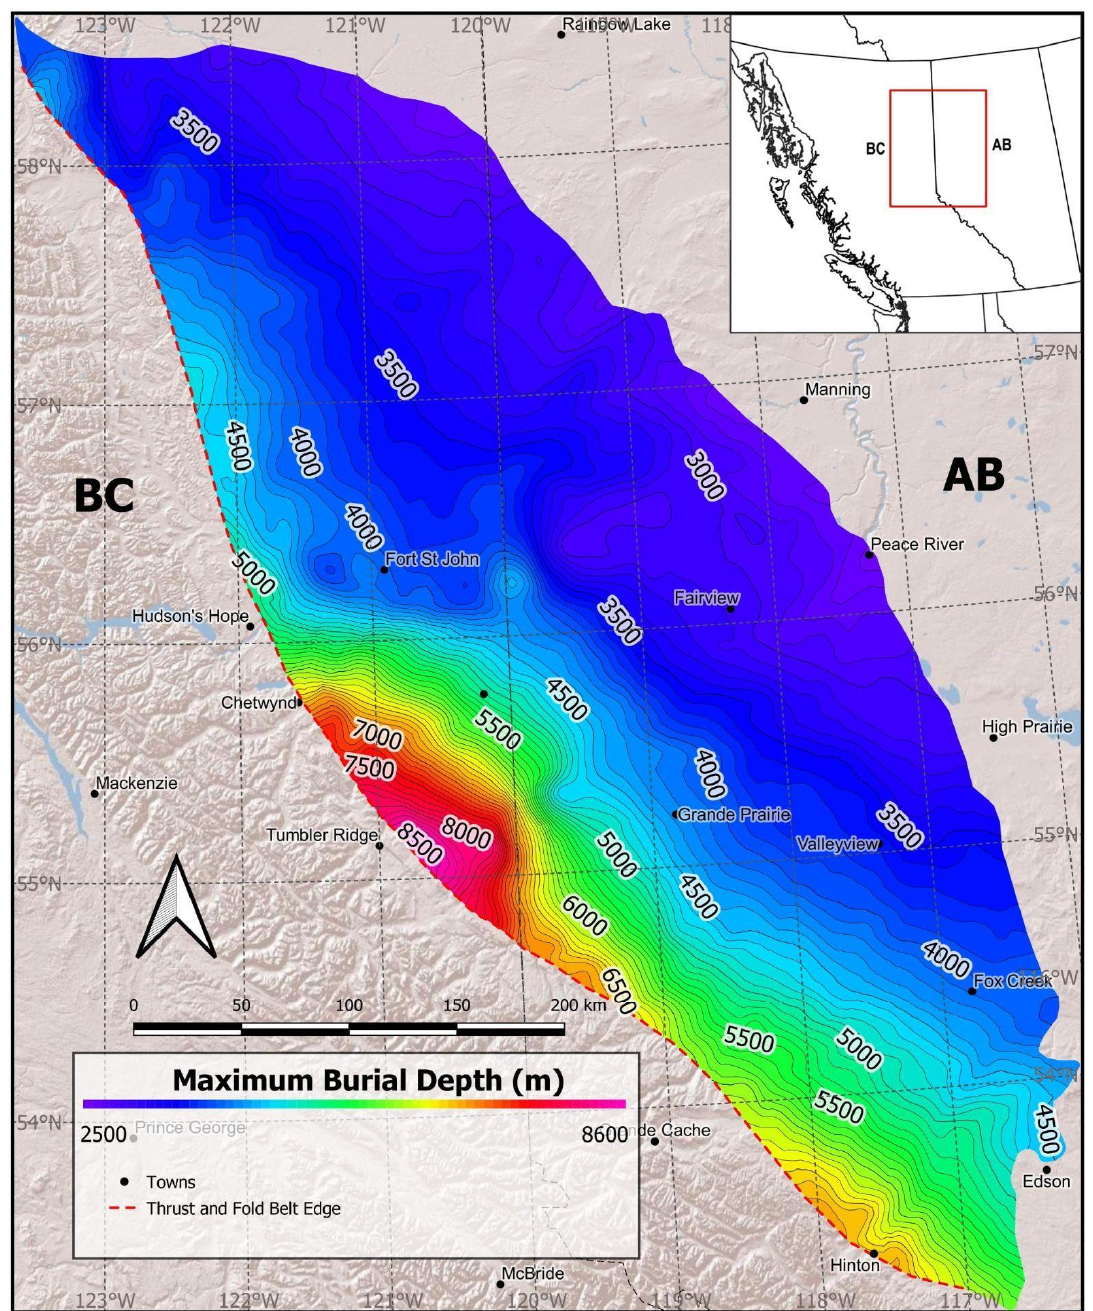
Figure 14. Maximum depth of burial of the Lower Montney Formation. No control points are shown on this map as the data were generated by Basin Model back-stripping simulation.